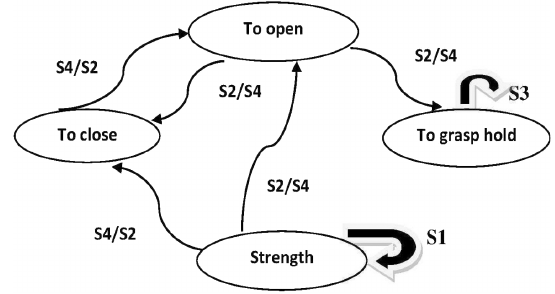
Fig. 3. The exercised activities for designed arm.